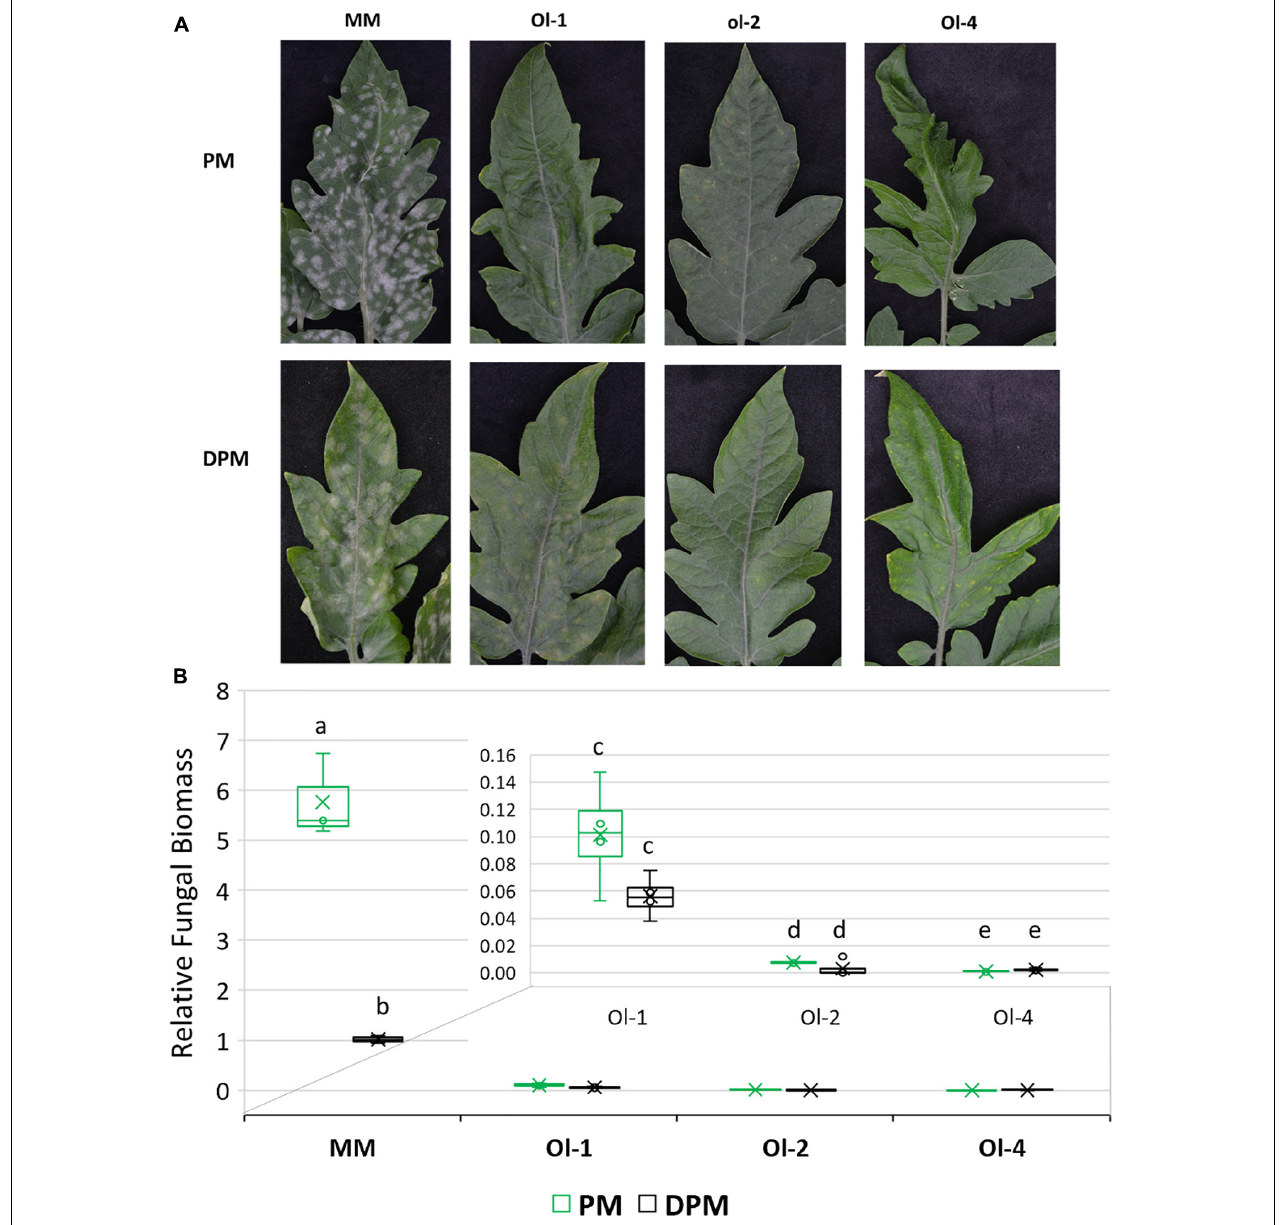
FIGURE 4 | (A) Disease symptoms visible as fungal sporulation on the adaxial surface of MM and Ol lines leaves under powdery mildew infection alone (PM) and combined moderate drought and powdery mildew infection (DPM). (B) Relative fungal biomass in MM and Ol lines under PM and combined stress DPM. Relative fungal biomass was calculated using the 2 - (cid:49) Ct method (Livak and Schmittgen, 2001) as the ratio between fungal internal transcribed spacer sequence and tomato EF1 α . Leaf samples for fungal biomass quantification and for making pictures were taken at 13 dpi.